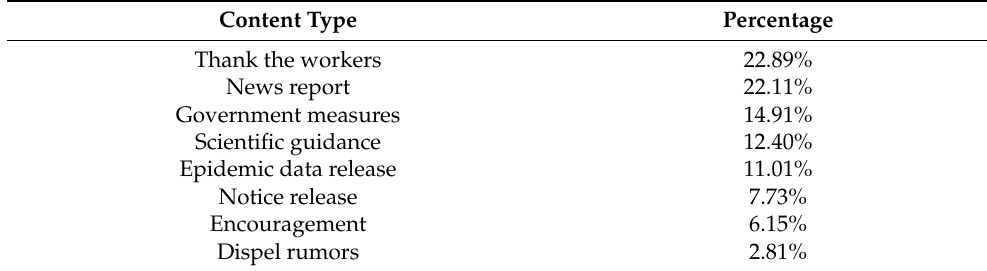
Table 3. Percentage of content